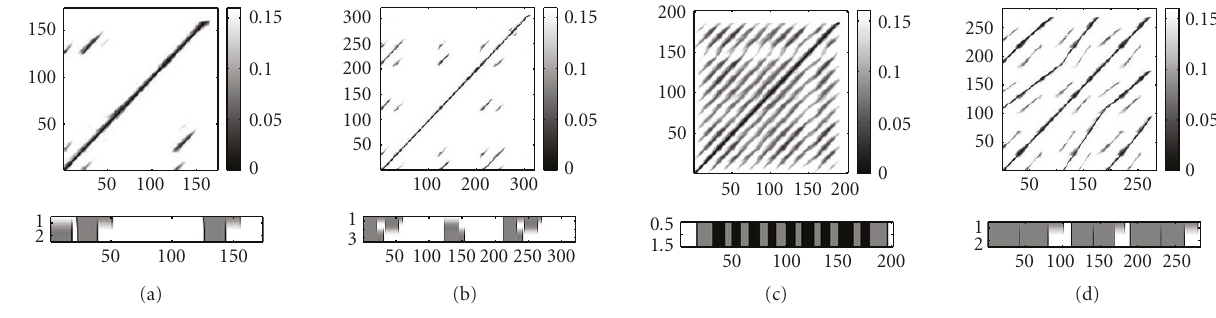
Figure 13: (a) Chopin, “Tristesse,” Etude op. 10/3, played by Varsi. (b) Beethoven, “Pathetique,” second movement, op. 13, played by Baren- boim. (c) Gloria Gaynor, “I will survive.” (d) Part A 1 A 2 B of the Shostakovich example of Figure 2 repeated three times in modified tempi (normal tempo, 140 percent of normal tempo, accelerating tempo from 100 to 140